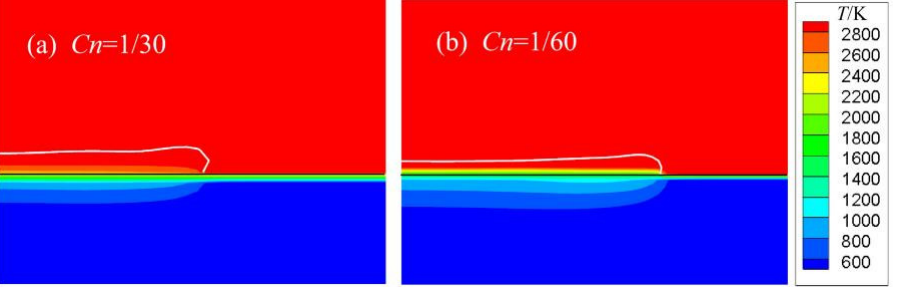
Figure 3. Temperature distribution for ( a ) Cn = 1/30 and ( b ) Cn = 1/60 at 0.6 μs. The white contour denotes Figure 2. Mesh independence test: spreading and solidification. Figure 2. Mesh independence test: spreading and solidification. drop profile and the temperature is measured in K. The substrate surface is denoted in black.